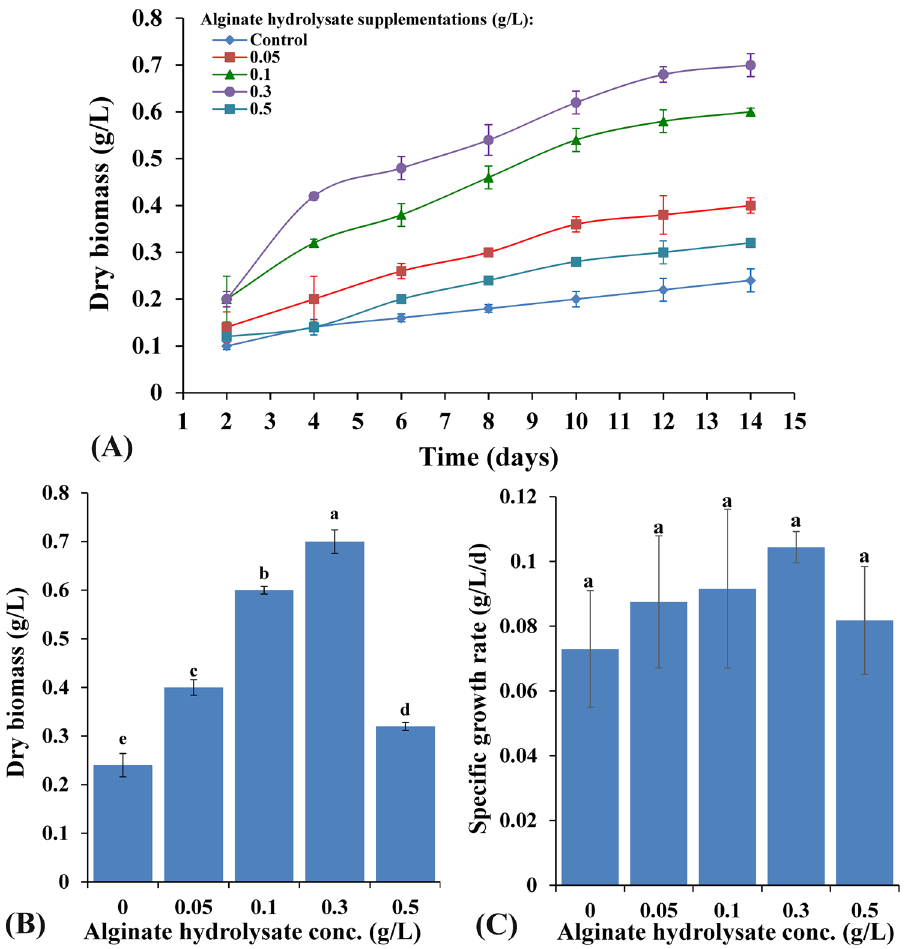
Figure 4. ( A , B ) Variation of C. vulgaris biomass content (mg/g dry wt) with different alginate hydrolysate supplementations (g/L) and ( C ) Variation of C. vulgaris specific growth rate (g/L/d) with different alginate hydrolysate supplementations